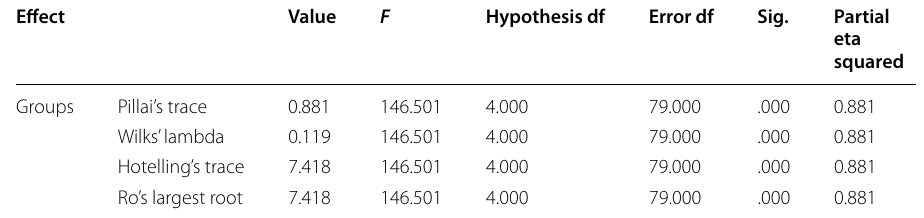
Table 4 MANOVA results comparing EG and CG on RCA posttest, AM posttest, FLA posttest, and SS-E posttest